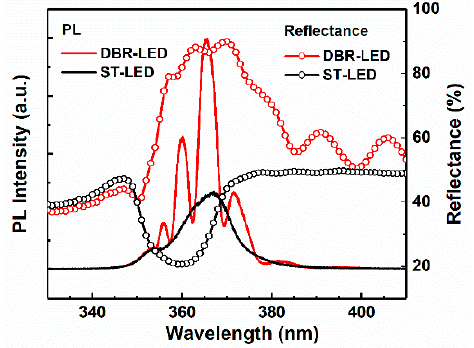
Figure 6. PL spectra and reflectance spectra of DBR-LED and ST-LED.